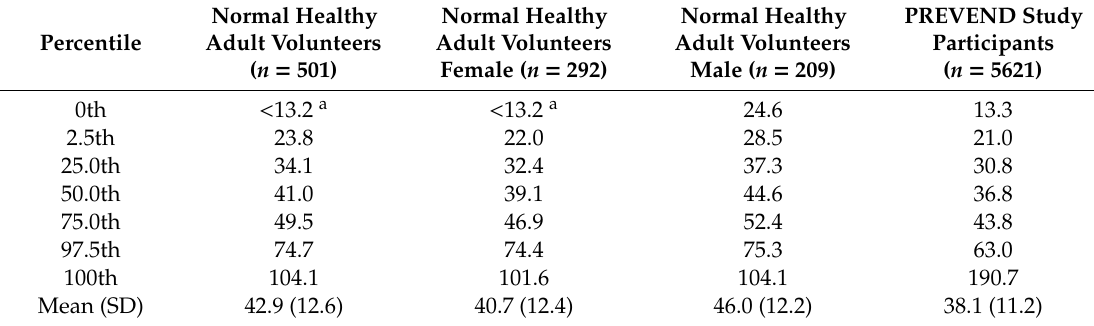
Table 2. Distribution and population means for betaine ( µ M) in generally healthy